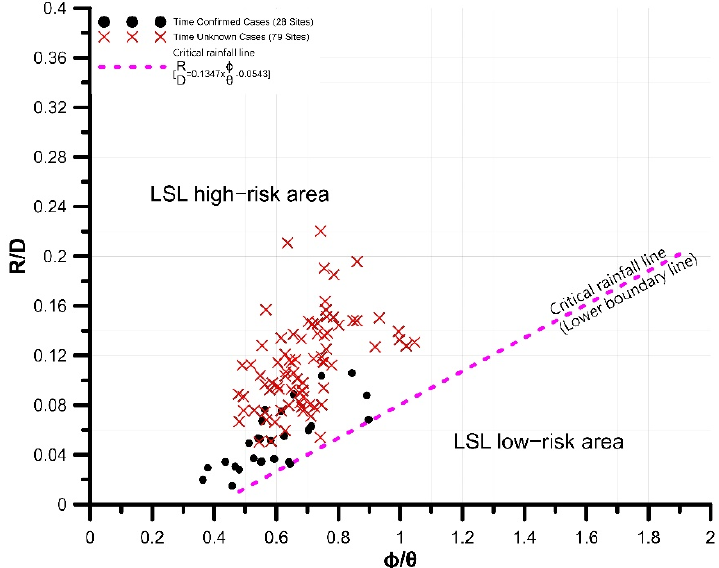
Figure 7. Dimensionless factor relationship of potential LSL area.